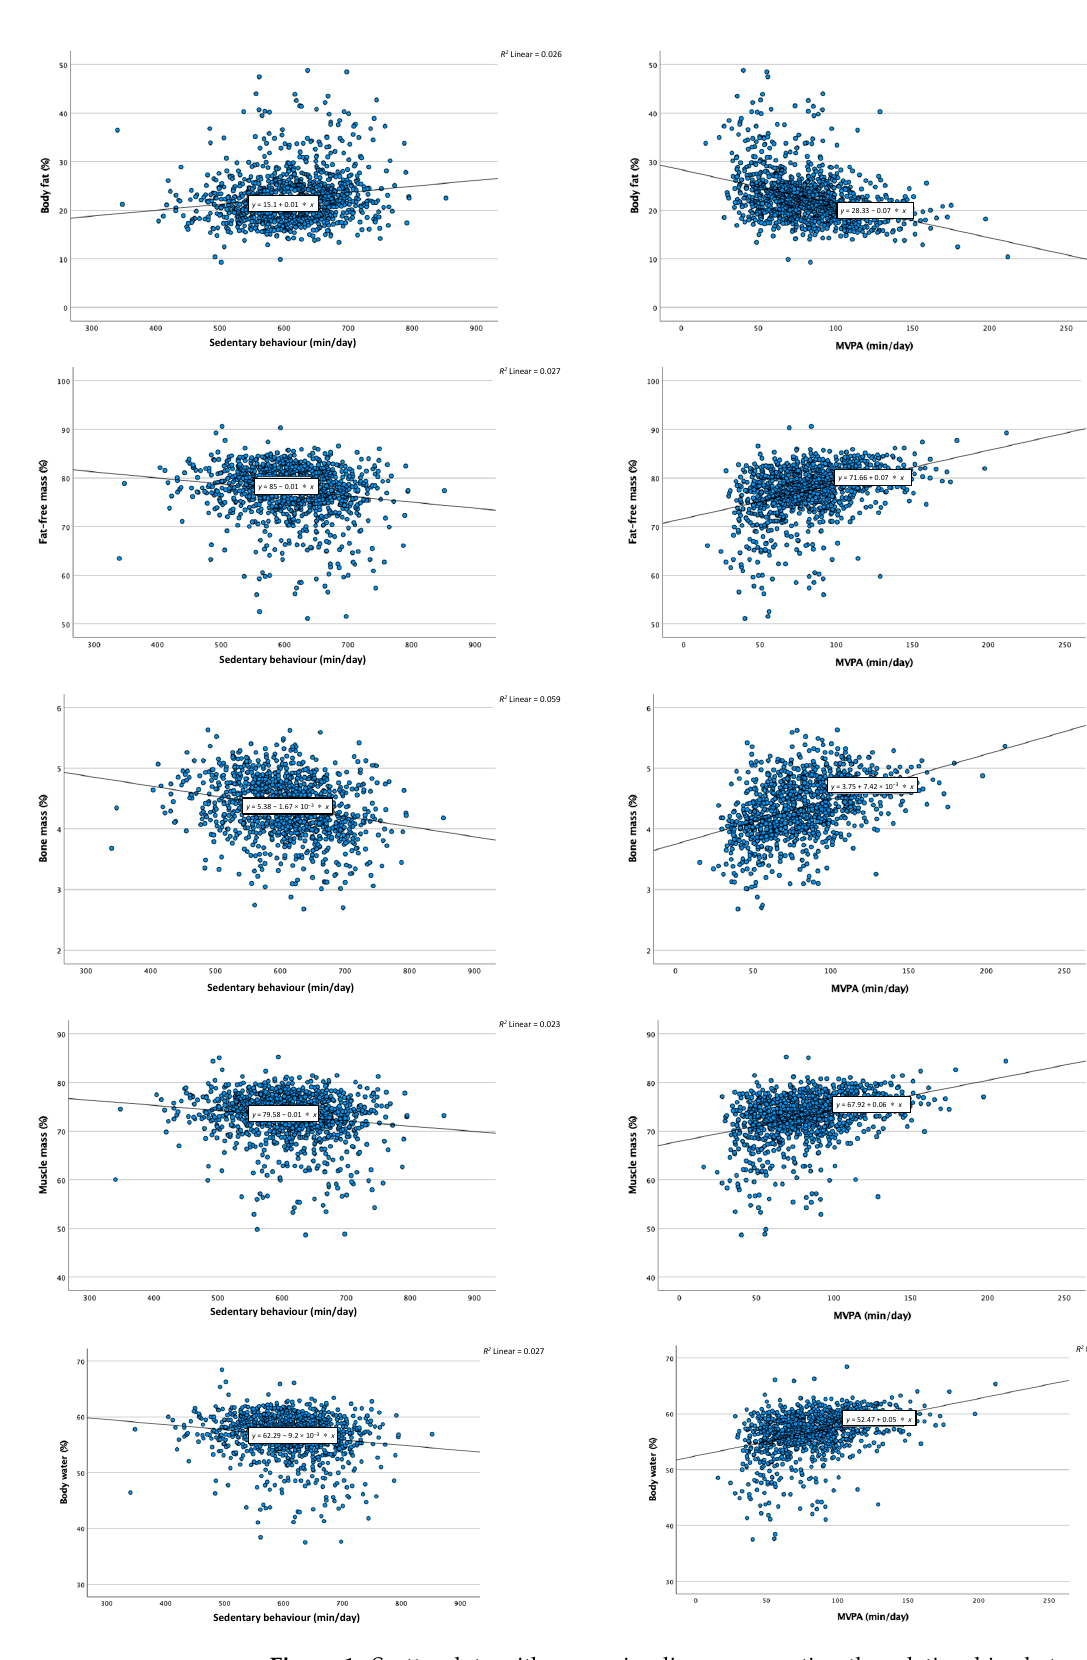
Figure 1. Scatterplots with regression line, representing the relationships between sedentary be- haviour and moderate-to-vigorous physical activity (MVPA) with the various body composition indicators. Notes. min = Minutes. R 2 = Total explained variance by regression